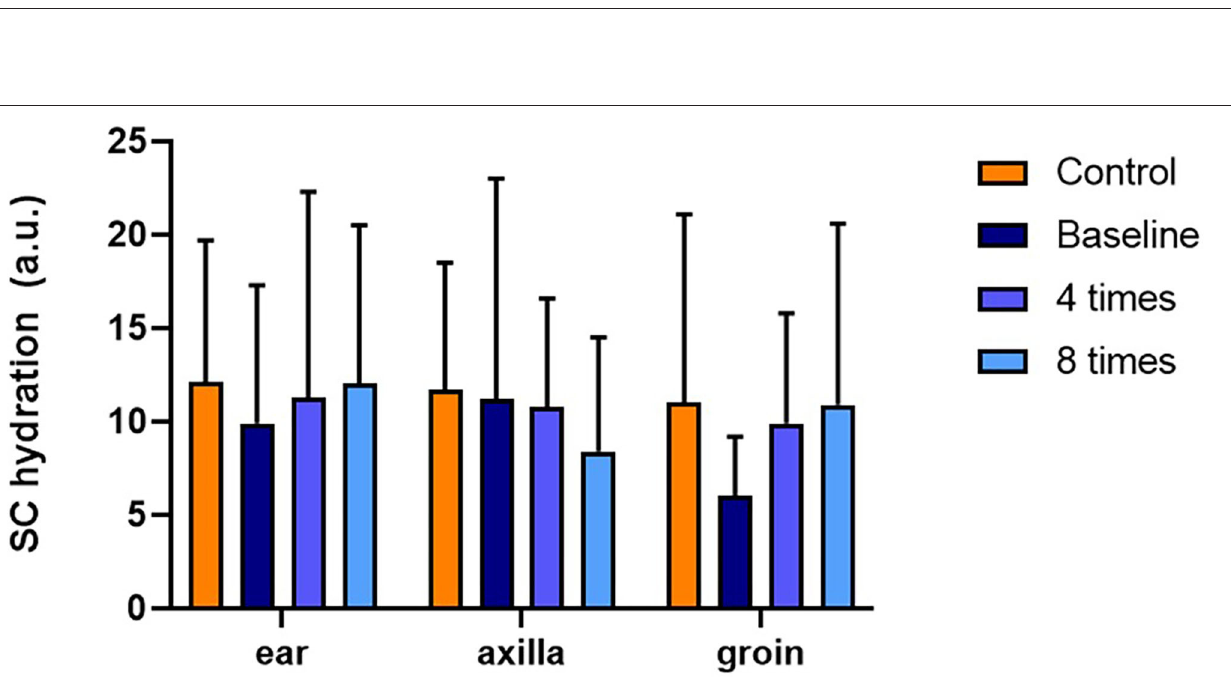
FIGURE 5 | Assessment of SCH with excimer light therapy. Difference in the SCH between the control and allergic groups and change in the SCH in the allergic group with excimer light therapy. Four times, fourth session of excimer light therapy in allergic group; eight times, end of the excimer light therapy in the allergic group; a.u., arbitrary unit; baseline, before the start of excimer light therapy in the allergic group; SCH, stratum corneum hydration. All values are expressed as means ± standard error.